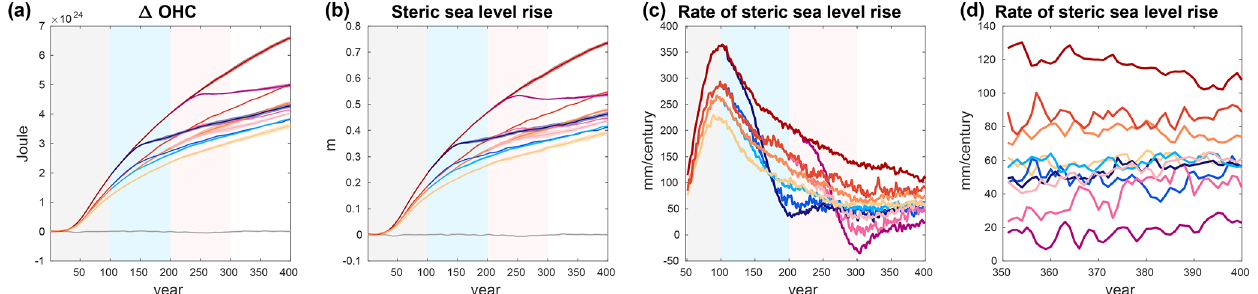
Figure 8. Ocean heat content (a) , steric sea level rise (b) , and rate of steric sea level rise smoothed over 50 years (c, d) . Panel (d) provides a zoom into the last 50 years of panel (c) . The colour code for the simulations is given in Fig. 1. The shading around the ensemble means indicates an estimate of internal variability as described in the text. An 11-year moving average filter has been applied to the time series in panels (a) and (b) . The shaded areas in the background indicate the different phases of the simulations (grey: positive emissions; light blue: negative emissions for the short overshoots; light red: negative emissions for the long overshoots).